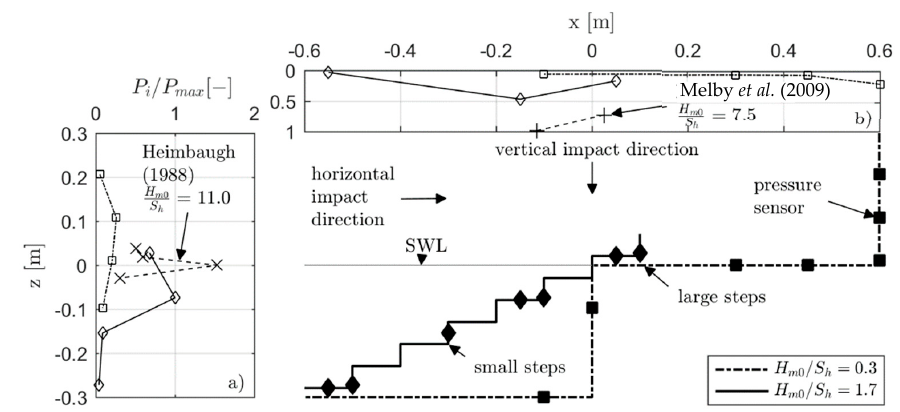
Figure 8. Horizontal ( a ) and vertical ( b ) relative maximum pressure impact distribution over large (dashed, Test 209, H m 0 = 0.089 m, and ξ = 2.8) and small (solid, Test 103, H m 0 = 0.084 m, and ξ = 2.9) stepped revetments.